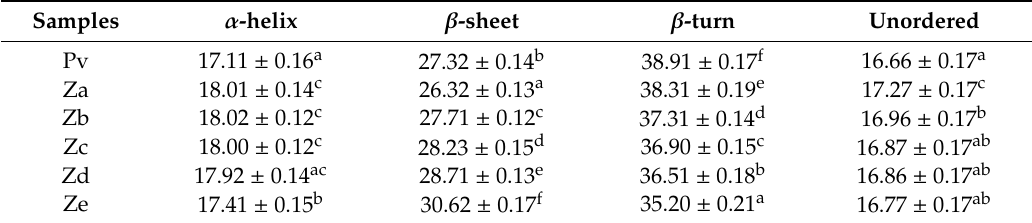
Table 1. Content of the secondary structure of the Pv–GA complexes.